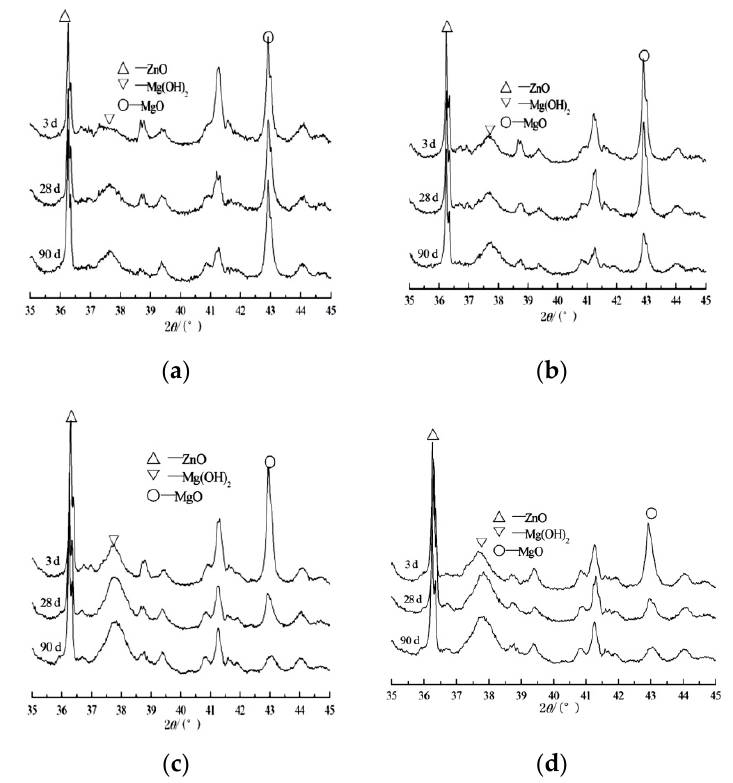
Figure 7. XRD pattern of hydration slurry mixed with MgO (190 s) at different temperatures: